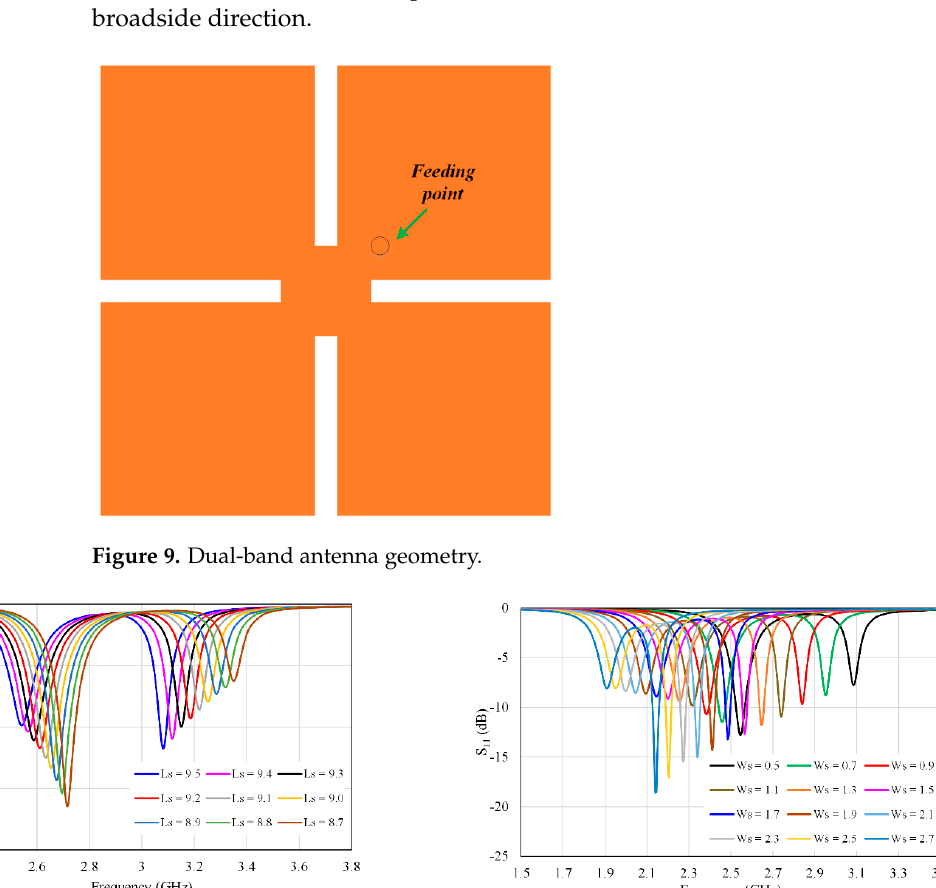
Figure 10. Frequency responses of slotted square patch antenna (dual-band) ( a ) for different Ls values, with Ws = 0.2 mm, and ( b ) for different Ws values, with Ls = 8.5 mm.